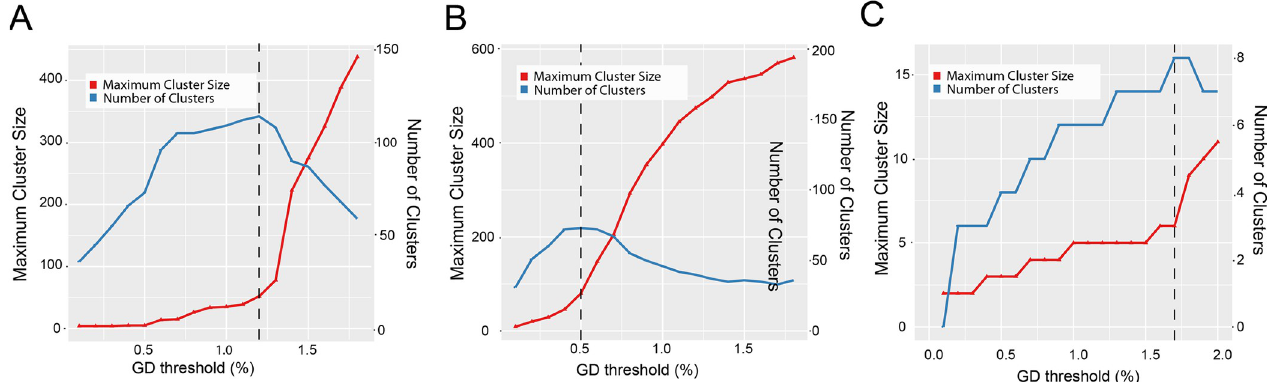
Fig 2. Genetic distance thresholds. (A–C) HIV transmission cluster amount and maximum cluster size with a range of GDs (0.1–2.0%) among subtypes CRF01_AE, CRF07_BC, and B. The red line depicts the maximum cluster size with GDs varying from 0.1% to 2.0%, whereas the blue line represents the number of clusters. The epidemiologically plausible range of thresholds for each subtype is highlighted with dashes.